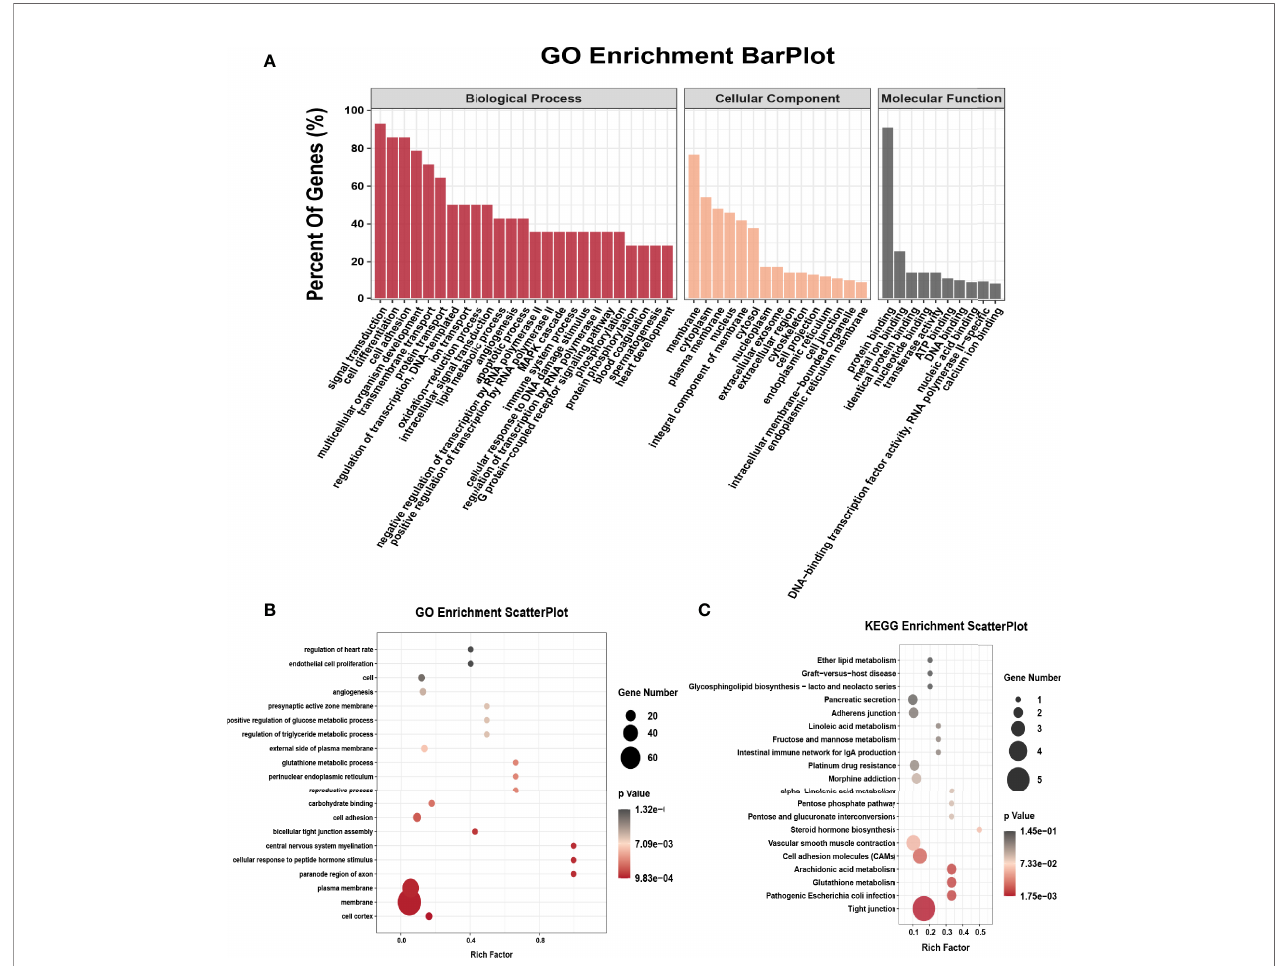
FIGURE 2 | GO and KEGG pathway enrichment of hyper-methylated m6A genes. (A) Major enrichment and meaningful GO terms of hyper-methylated m6A genes in EOC. (B) The top 20 signi fi cant GO enrichment terms with m6A hypermethylation. (C) The top 20 signi fi cant KEGG pathways with m6A